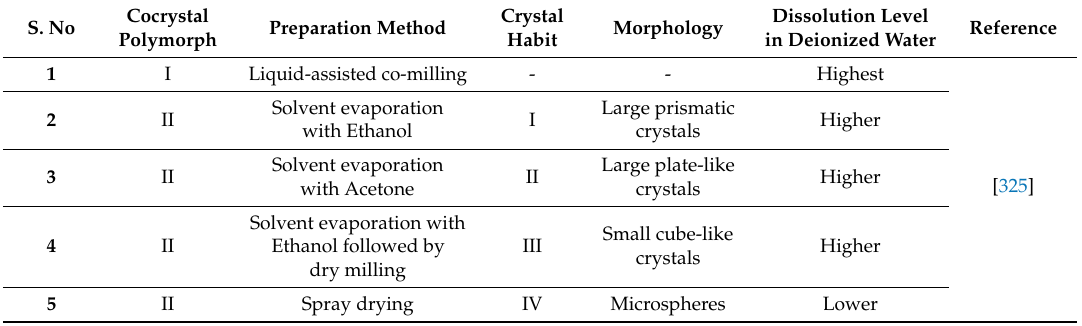
Table 12. Different crystal habits of Sulfadimidine-4-aminosalicylic acid (1:1) cocrystals [305]. S.